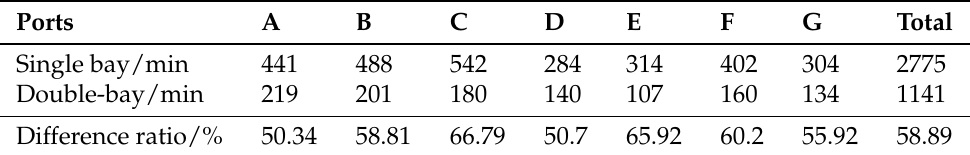
Table 8. Comparison of the berthing times between the single bay and double-bay.